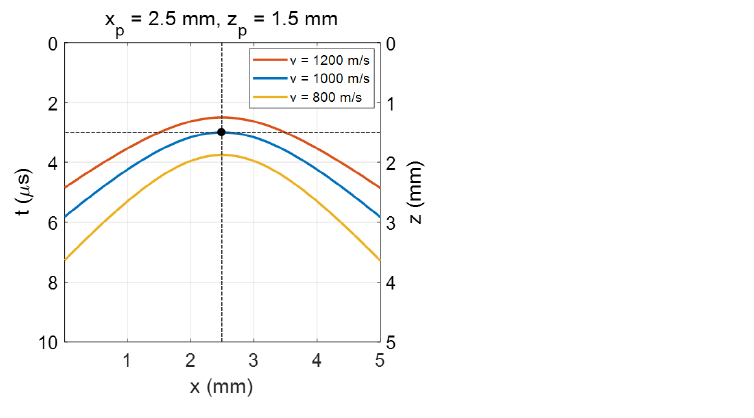
Figure 2. The hyperbolic curves simulated with the same target position but with different acoustic velocities. The minimum time delay and the slope of curve were changed with the velocity variation.